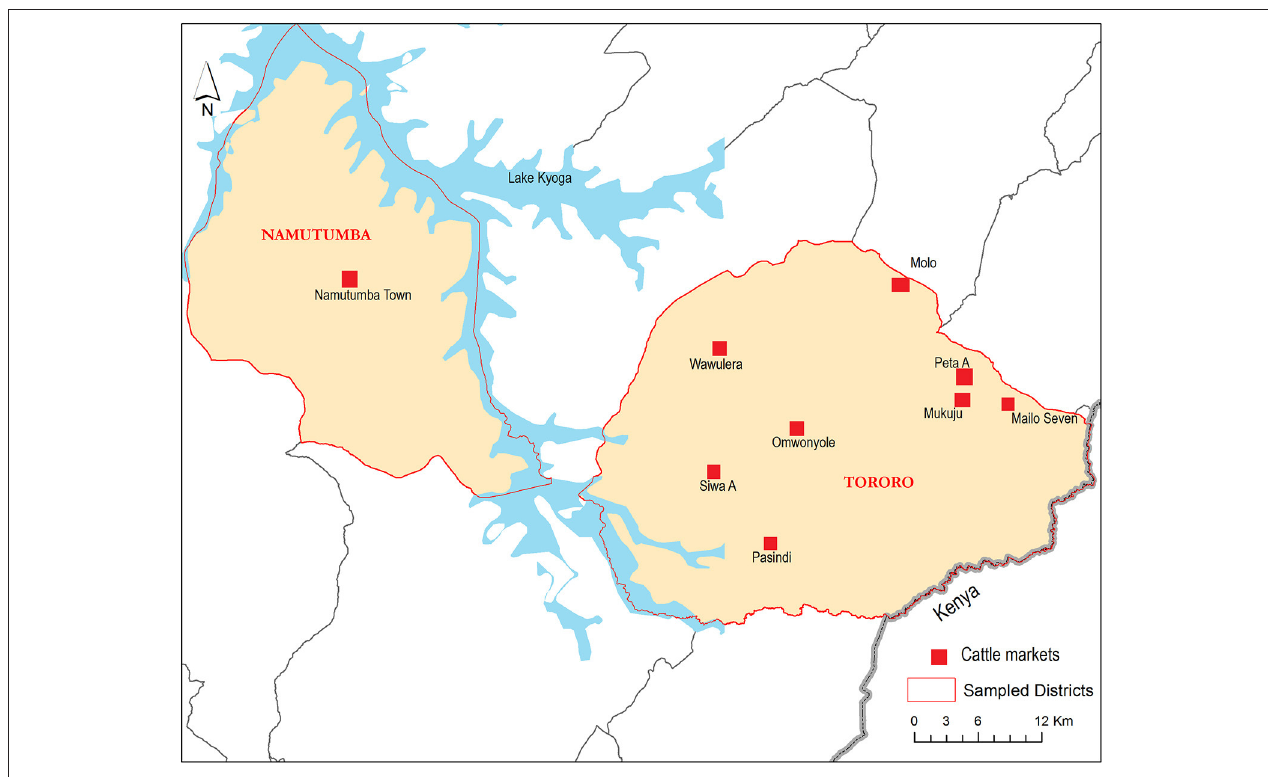
FIGURE 2 | Map showing Tororo and Namutumba Districts and where the cattle market data was collected (in red). Water bodies are shown in